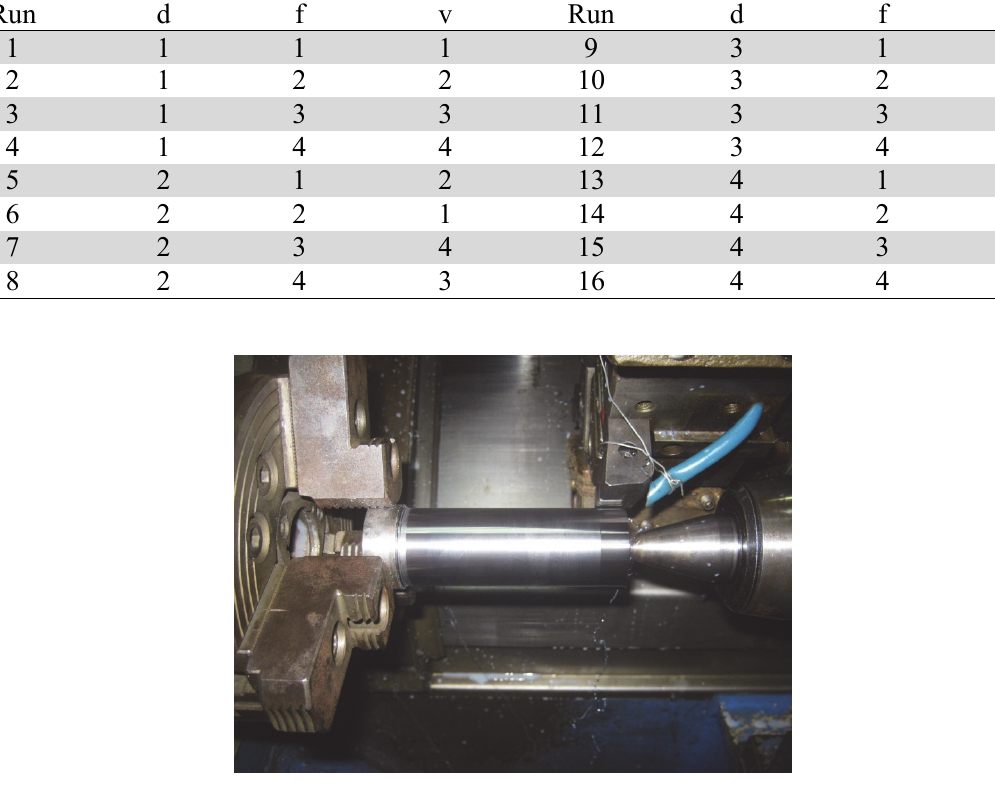
Taguchi L 16 orthogonal array